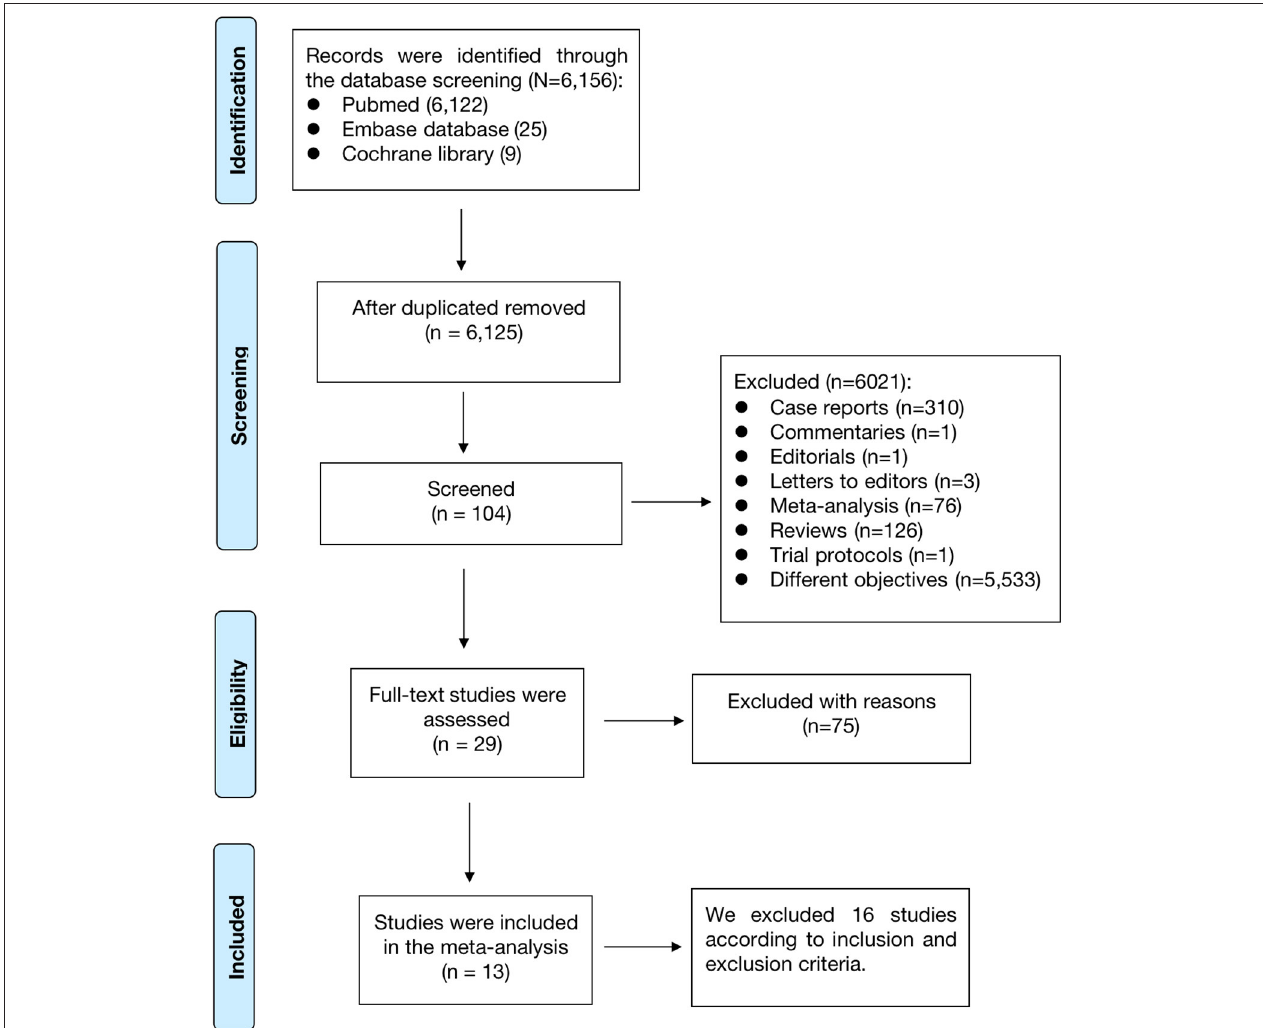
FIGURE 1 | The process of the literature search of this meta-analysis.